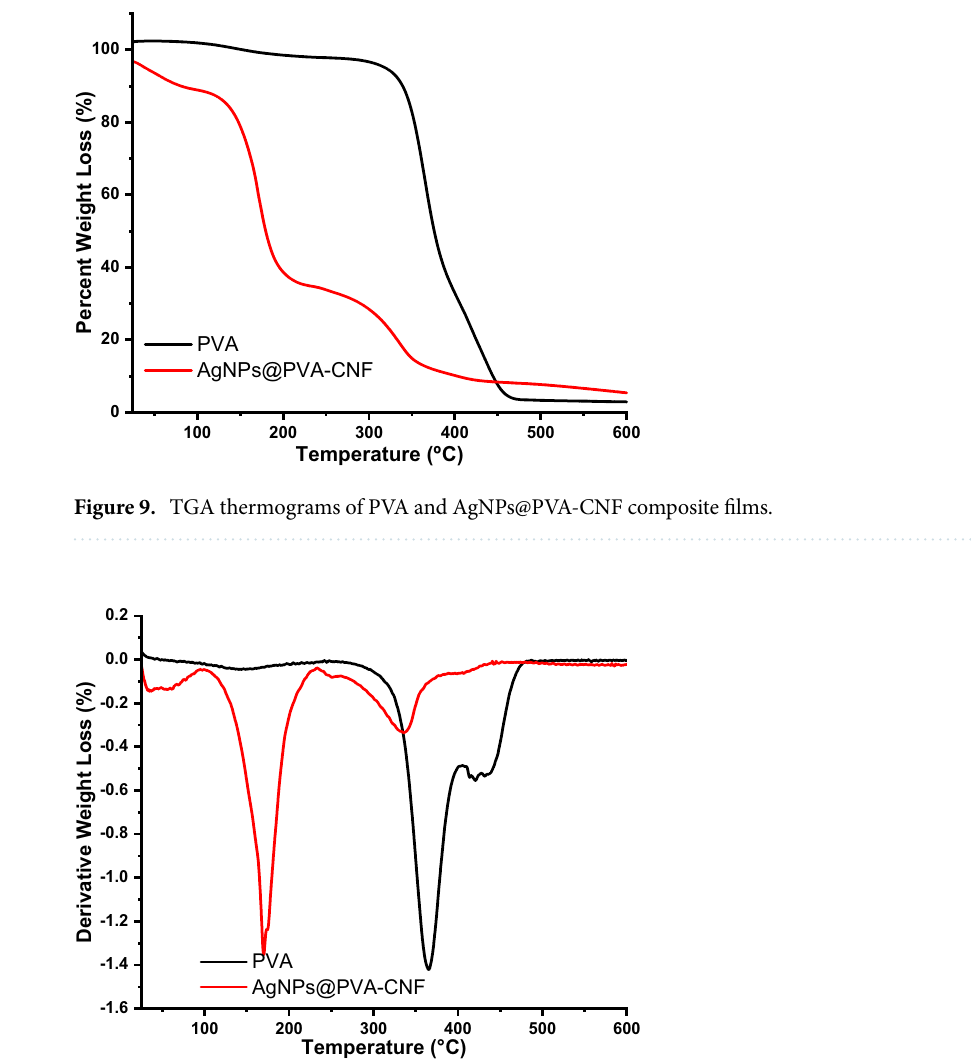
Figure 10. TGA thermograms of PVA and AgNPs@PVA-CNF composite